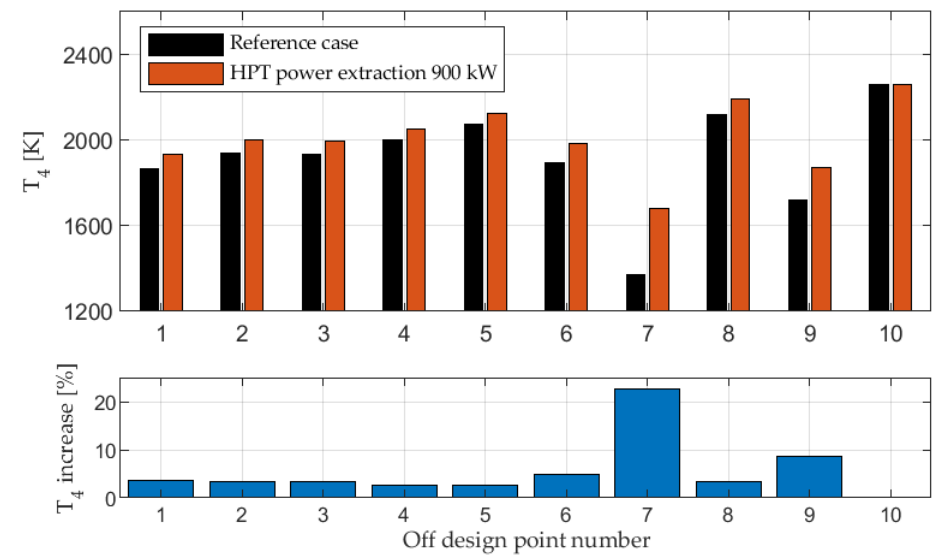
Figure 5. Turbine inlet temperature, T 4 , with and without HPT power extraction.